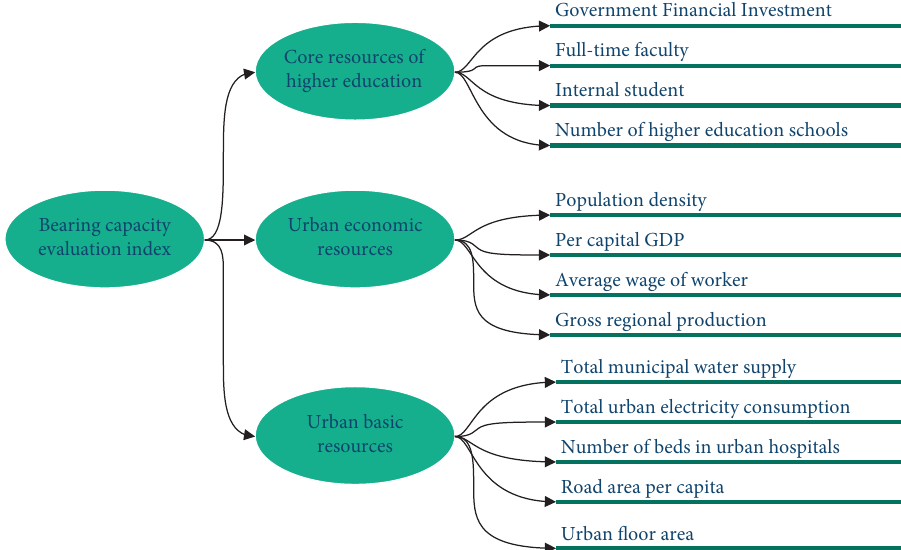
Figure 2: Evaluation index System diagram of urban higher education resource carrying capacity.